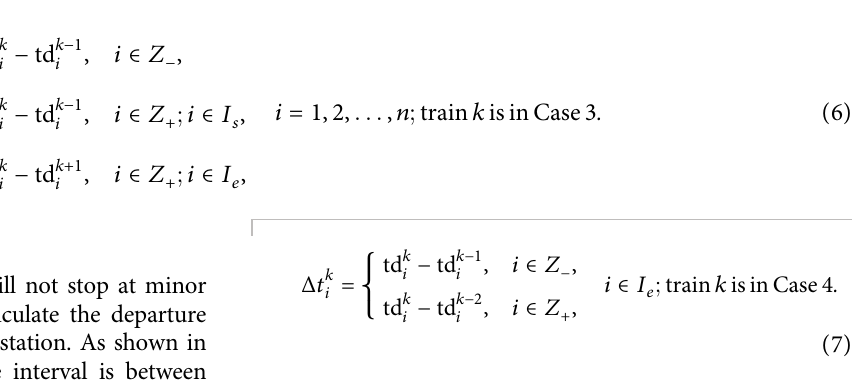
Figure 5: Illustration for TDC when the ratio is